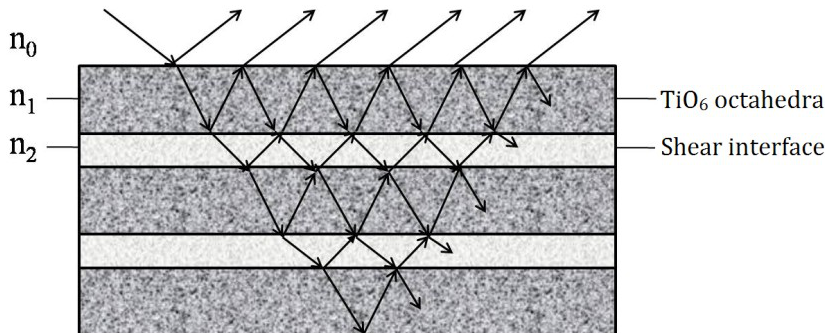
Figure 5. Schematic reflectance in the layered perovskite